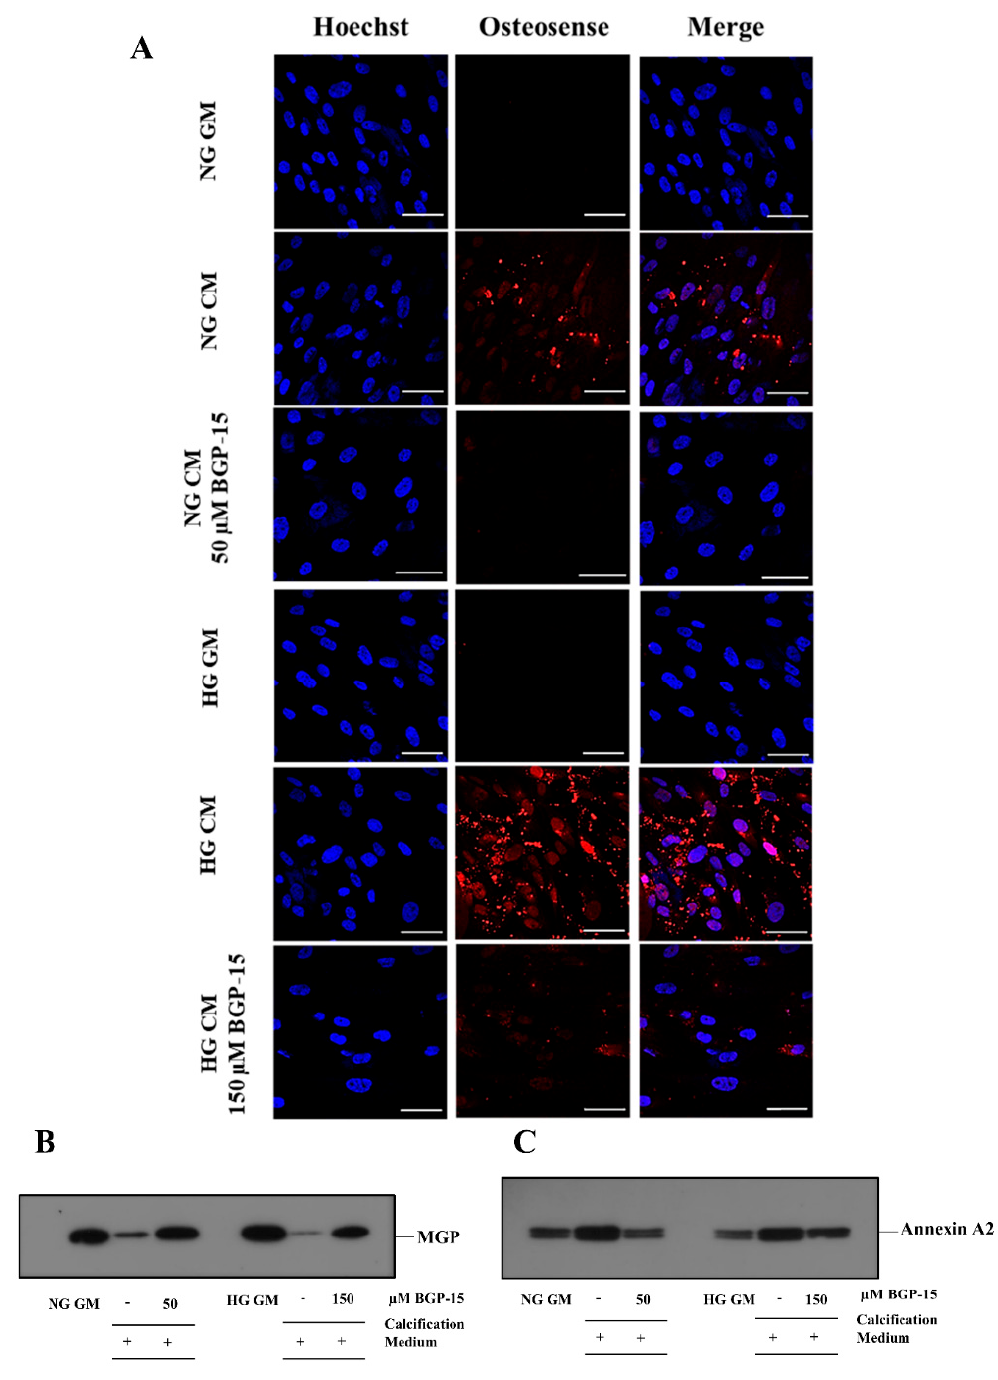
Figure 11. BGP-15 decreases microcalcification, the loss of MGP, and the induction of Annexin A2 induced by high Pi in NG and HG conditions. ( A ) VSMCs were treated as in Figure 2 using 50 µ M BGP-15 under NG and 150 µ M under HG conditions for 10 days, then plated to glass coverslips. Calcium deposition was visualized by OsteoSense 680. Nuclei were counterstanied with Hoechst staining. Bar represents 50 µ m. ( B ) BGP-15 attenuates the loss of MGP induced by high Pi in NG and HG conditions. VSMCs were treated as in Figure 2 using 50 µ M BGP-15 under NG and 150 µ M under HG conditions for 10 days, EVs were analyzed by immunoblotting. ( C ) BGP-15 decreases Annexin A2 expression induced by high Pi in NG and HG conditions. VSMCs were treated as in Figure 2 using 50 µ M BGP-15 under NG and 150 µ M under HG conditions for 10 days, EVs were analyzed by